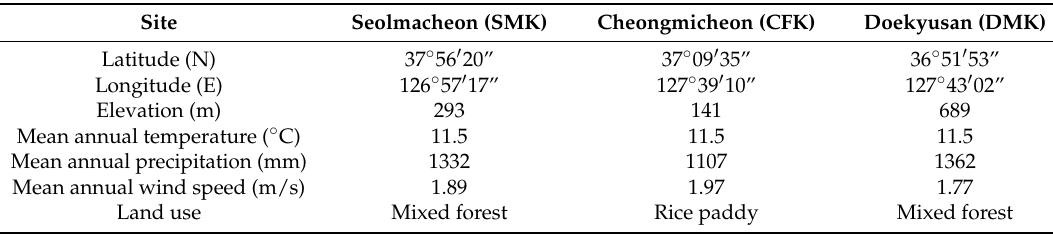
Table 1. Summary of the three flux